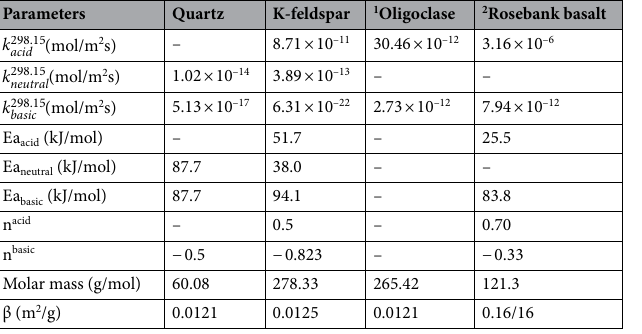
Table 2. Parameters used for modelling of primary minerals. Data for quartz and K-feldspar were taken from 63 . Rate equation data for oligoclase was taken from 65 and is stated in the Theoretical background. 1 See theoretical background text for rate equation parameters. 2 Calculated based on 63 .